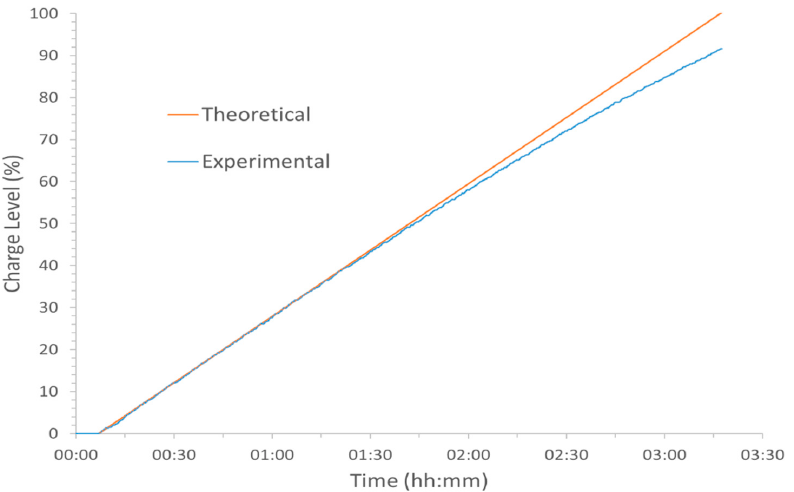
Figure 10. Predicted theoretical charge level and actual charge level (from OCV) at 200 kW charge.